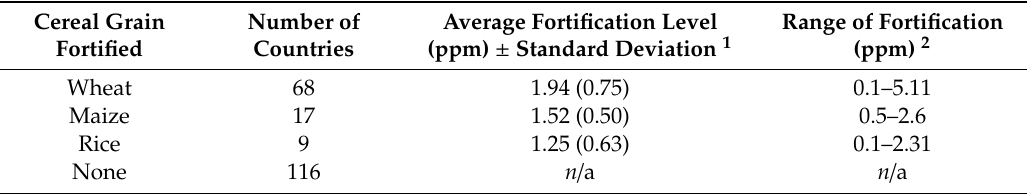
Table 1. Fortification levels of folic acid as a function of cereal